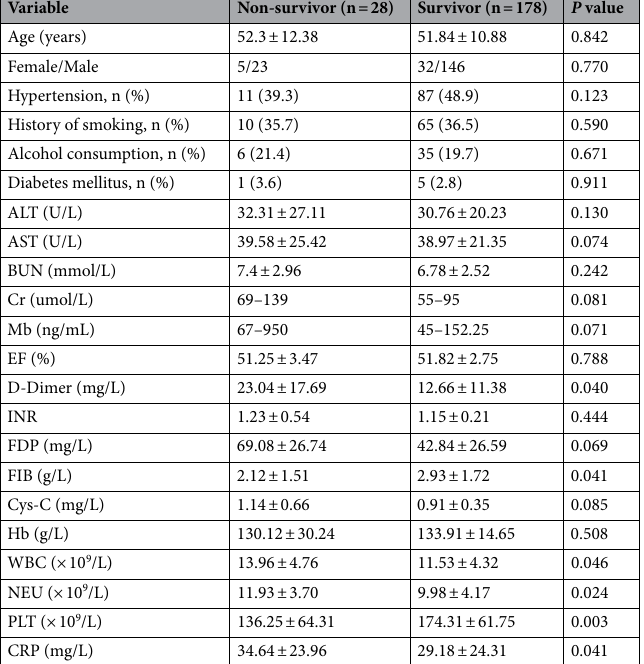
Table 1. Baseline characteristics between the death group and the survival group. Data are mean ± SD, or median (interquartile range), n (%). ALT, alamine aminotransferase; AST, aspartate transaminase; BUN, blood urea nitrogen; Cr, creatinine; Mb, myoglobin; EF, ejection fraction; INR, international normalized ratio; FDP, fibrinogen degradation product; FIB, fibrinogen; Hb, hemoglobin; Cys-C, Cystatin C; WBC, white blood cells; NEU, neutrophil; PLT: platelet; CRP, C reactive